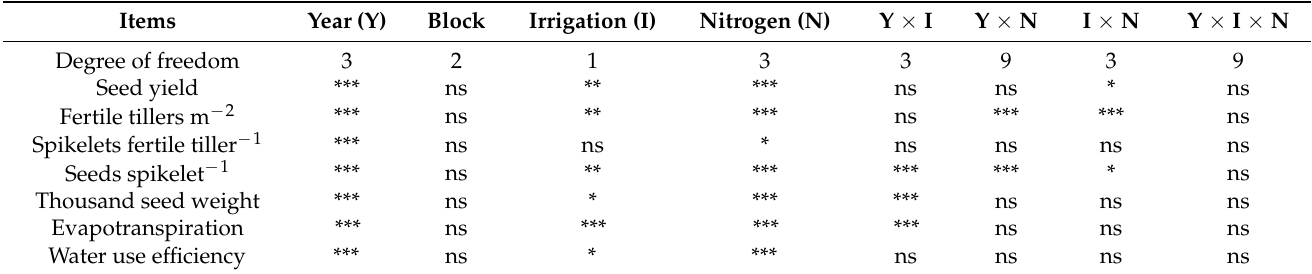
Table 1. Analysis of variance for year, block, irrigation, nitrogen application, and their interaction effects on seed yield, yield components, evapotranspiration, and water use efficiency of Cleistogenes songorica .